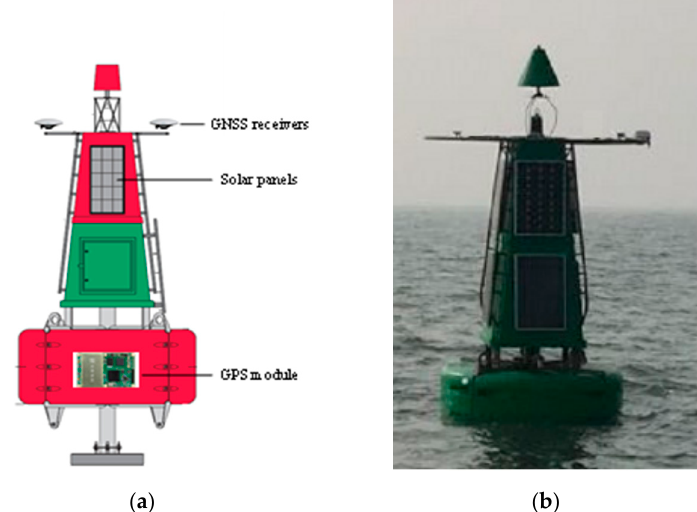
Figure 8. Structure of the multi-functional buoy. ( a ) Shows installation position of GPS receivers, GPS module and solar panels; ( b ) shows the buoy at the testing field. GNSS: global navigation satellite system.